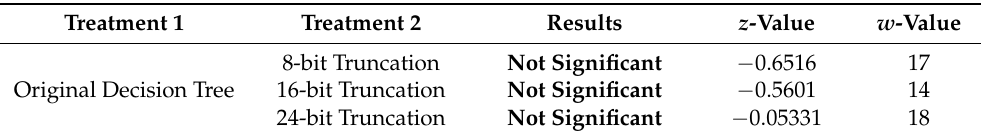
Table 9. Performance Comparison of Pruning with IP Truncation Versus Original Decision Tree using Wilcoxon Signed-Rank